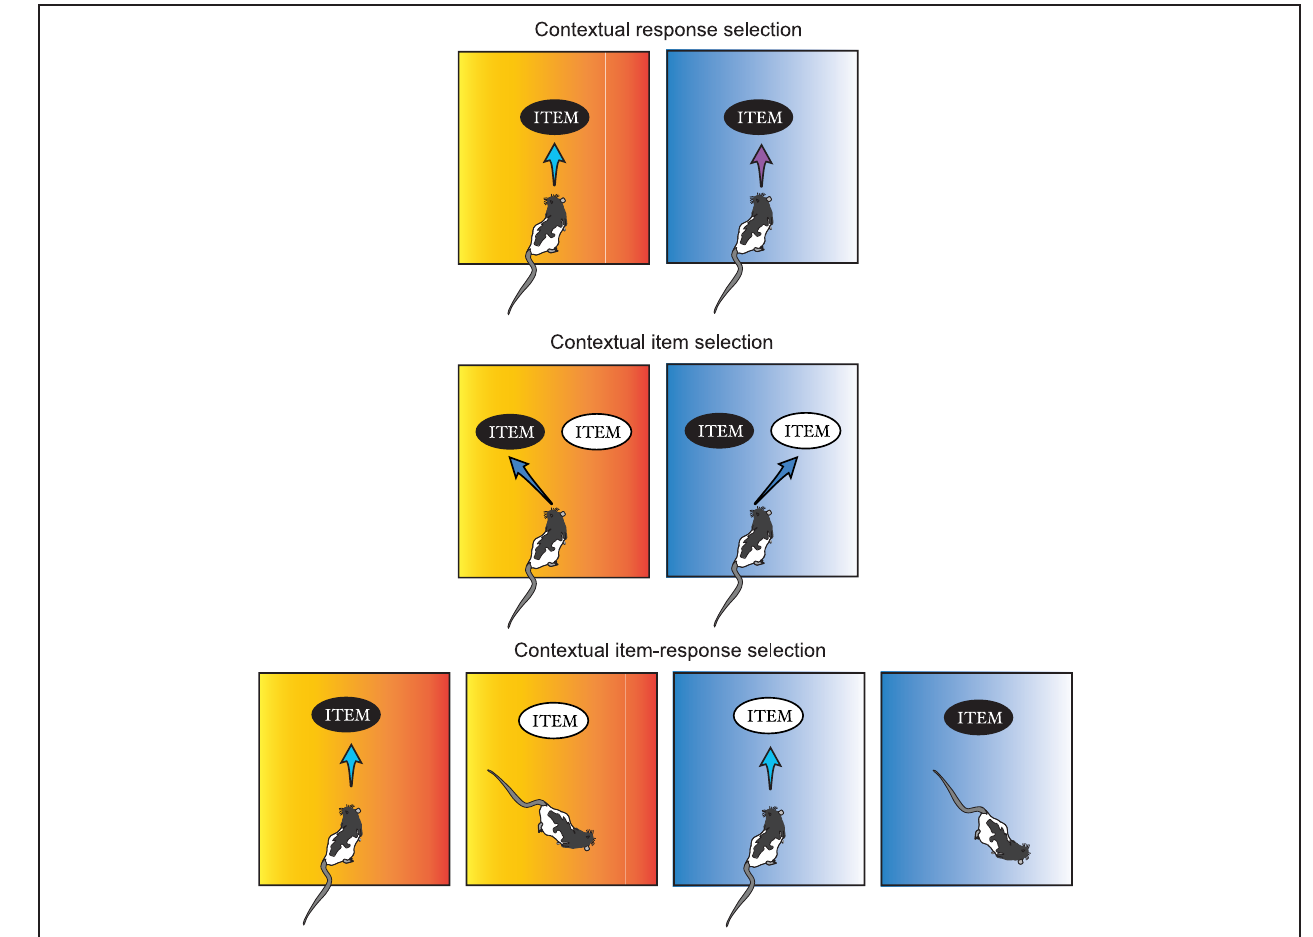
context is associated with the item. Contextual item selection : an animal gives out the same type of responses to different items depending on the contextual information. Contextual item–response selection : an animal responds to an item (e.g., black item) when itisidentified inone context (e.g., orange context), but not when it is encountered in another context (e.g., blue context), and vice versa for the other item (e.g., white item).